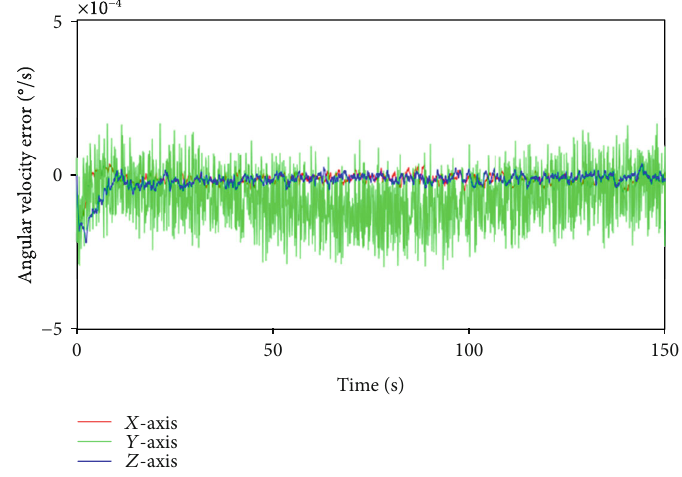
Figure 7: Angular velocity error of the PID controller with the optimal coe ffi cient combination.